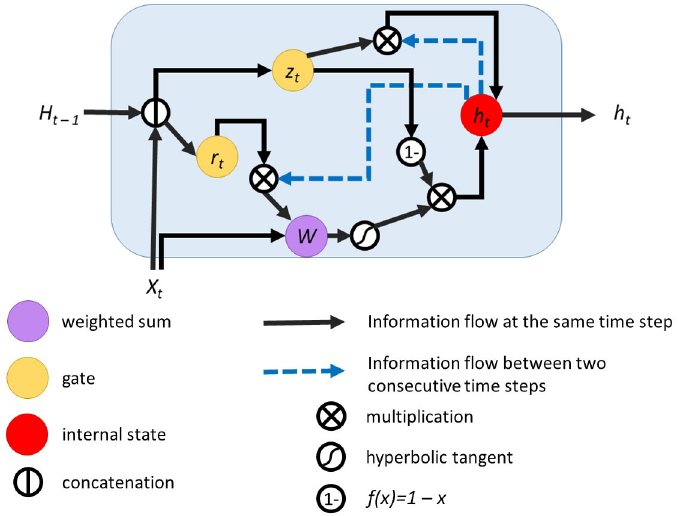
Figure 4. Gated recurrent